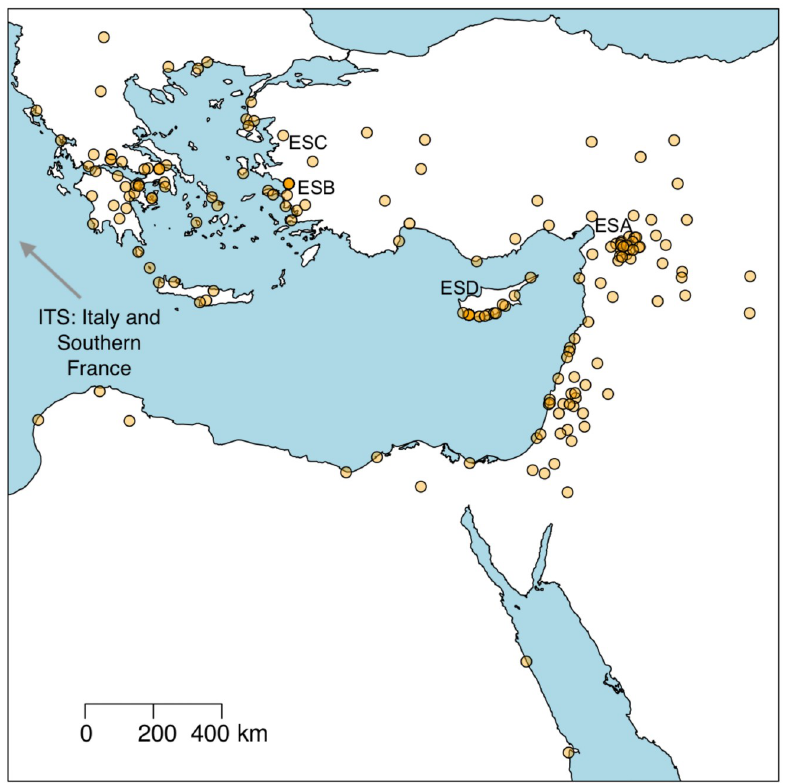
Fig 2. Geographical distribution. Geographical distribution of the 178 eastern Mediterranean sites from the ICRATES database. Each point represents one archaeological site. Presumed production regions of ESA, ESB, ESC, ESD are labeled. Map created using data from Natural Earth (http://www.naturalearthdata.com/).